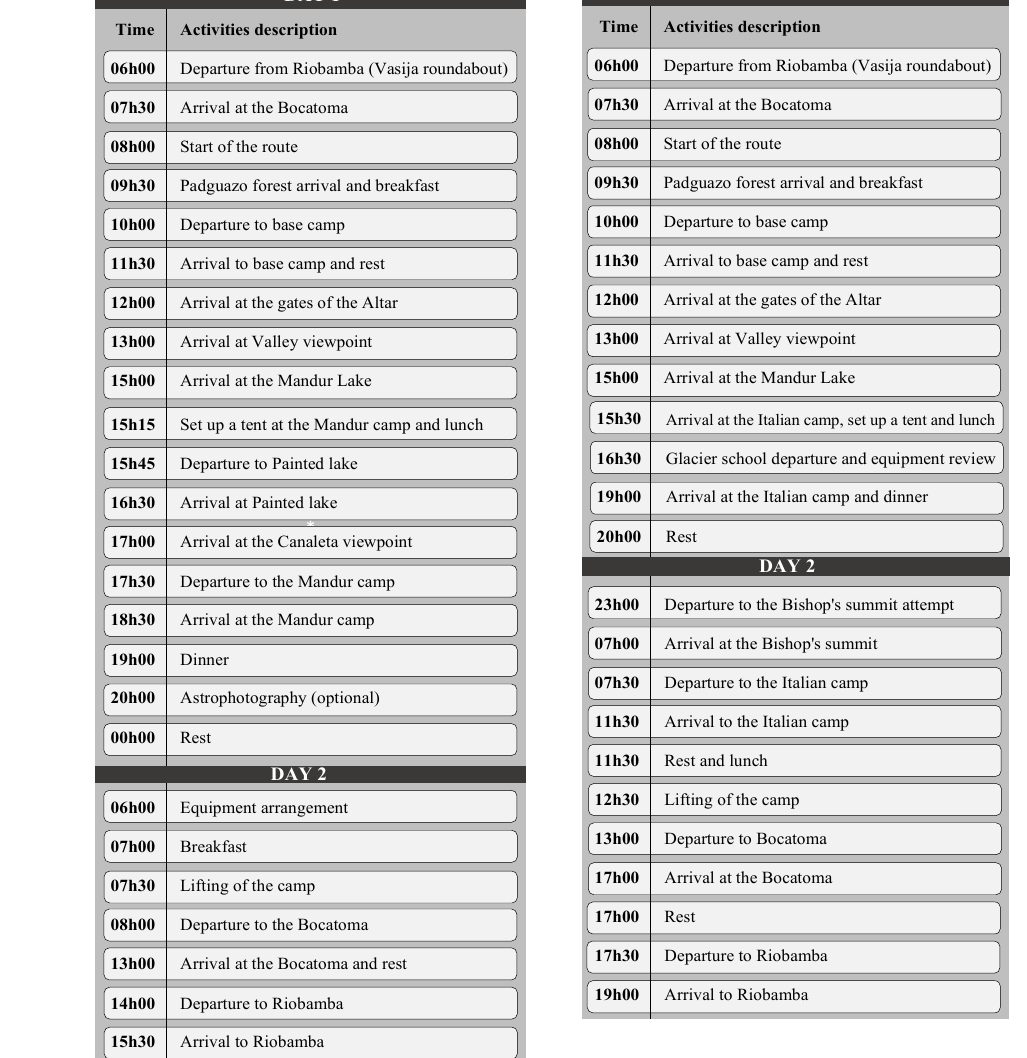
Figure 8. Itinerary of the route.